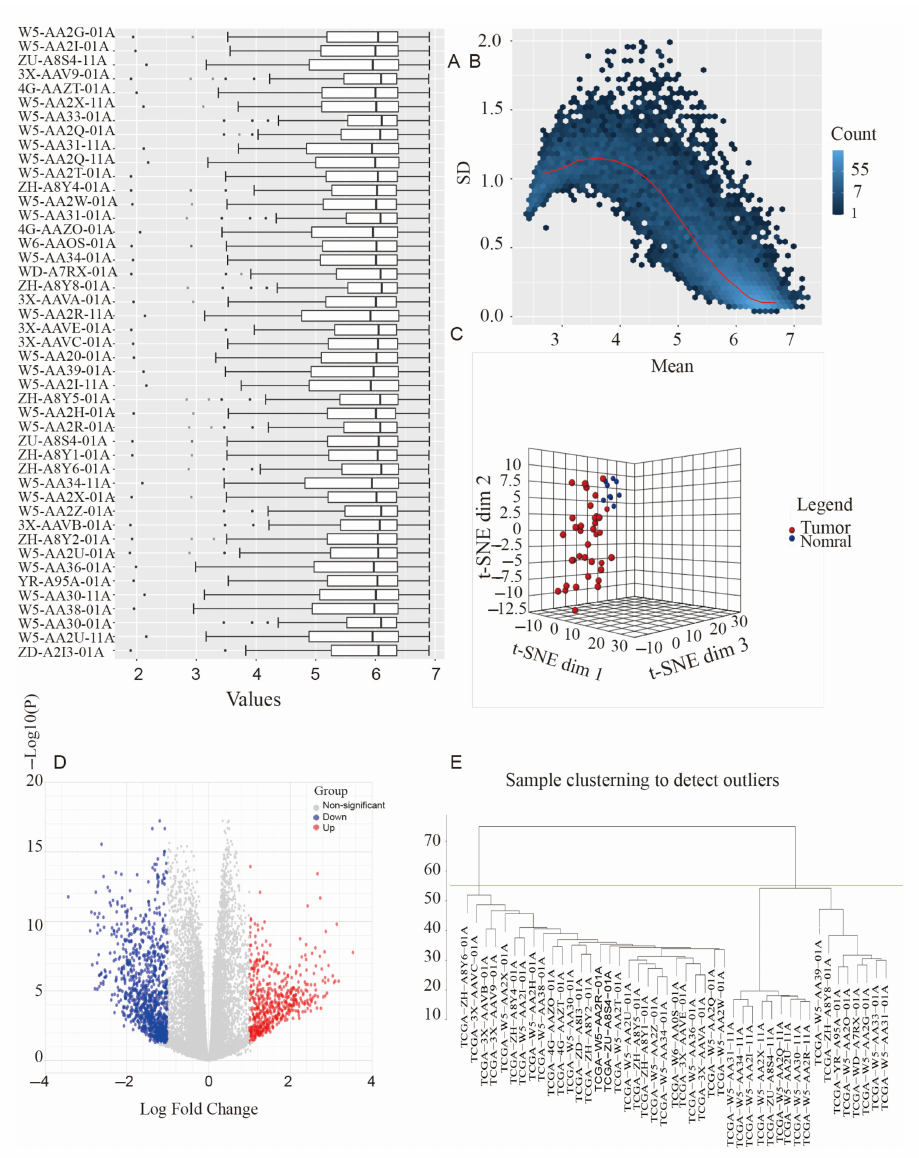
Figure 2. Identification of DEGs for analysis. ( A ) Box plot of 45 samples after normalization (log2- counts per million, variance filter: 15; low abundance: 4). ( B ) MSD plot of 45 samples after normal- ization. ( C ) t-Distributed stochastic neighbor embedding of DEGs demonstrated that CCA patients and nontumor tissues would be divided into two groups. ( D ) Volcano plot of 1613 DEGs in between CCA patients and normal tissue (adjusted p -value < 0.05; |log2fold change| > 1). ( E ) Plot of sample clustering. Set model parameters “cutHigh” and “minSieze” were set at 55 and 10, which ultimately yielded 28